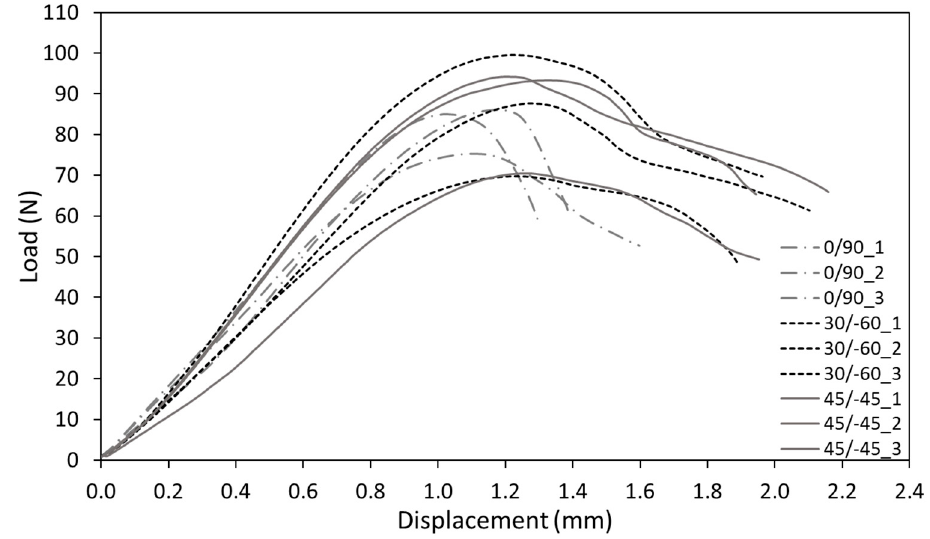
Figure 5. The stress-strain curves of the AM ABS material for the three different raster orientations.